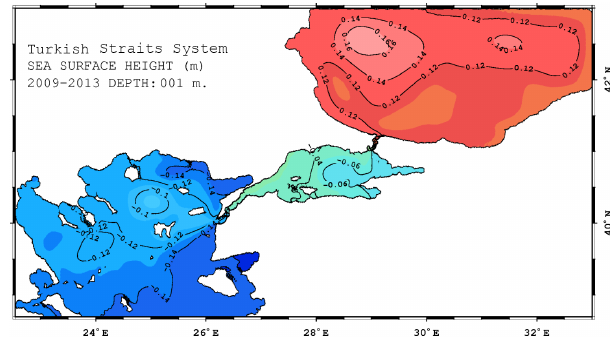
Figure 10. The mean sea surface height for 2009–2013. Contours are overlaid with 2cm